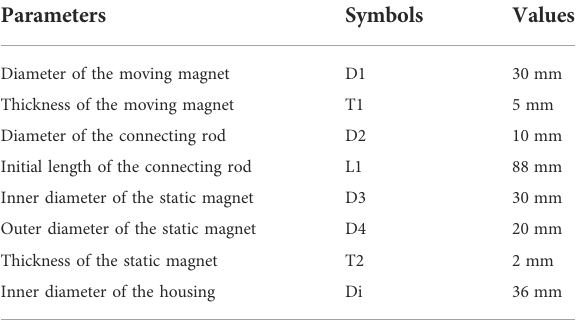
TABLE 1 Main structural dimensions of the varying stiffness magnetic fl uid shock absorber.